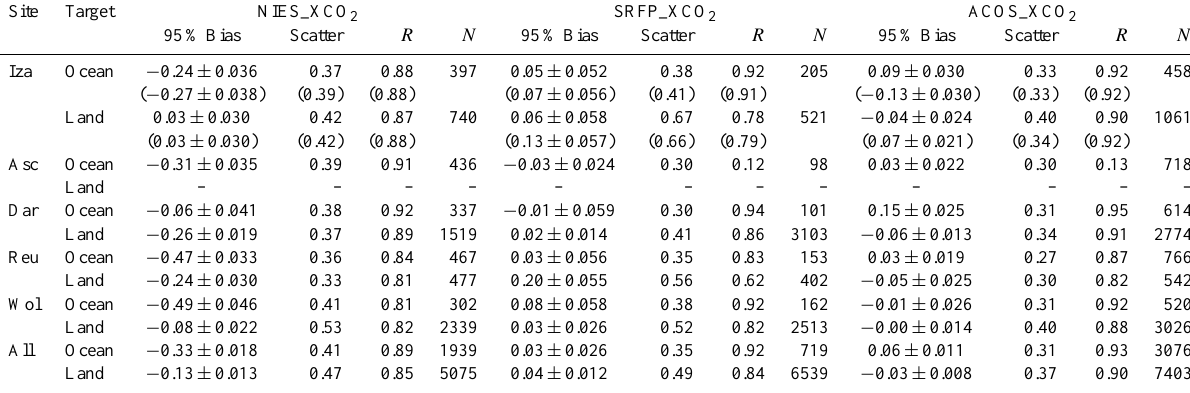
Table 3. XCO 2 results of NIES, SRFP and ACOS algorithms at 5 TCCON stations based on all individual satellite–TCCON data pairs. The 95% confidence interval of relative bias, relative scatter, R and N are defined in Sect. 3.4. Between brackets are the results without altitude correction. Positive/negative bias means the FTIR measurement is less/larger than the GOSAT product.